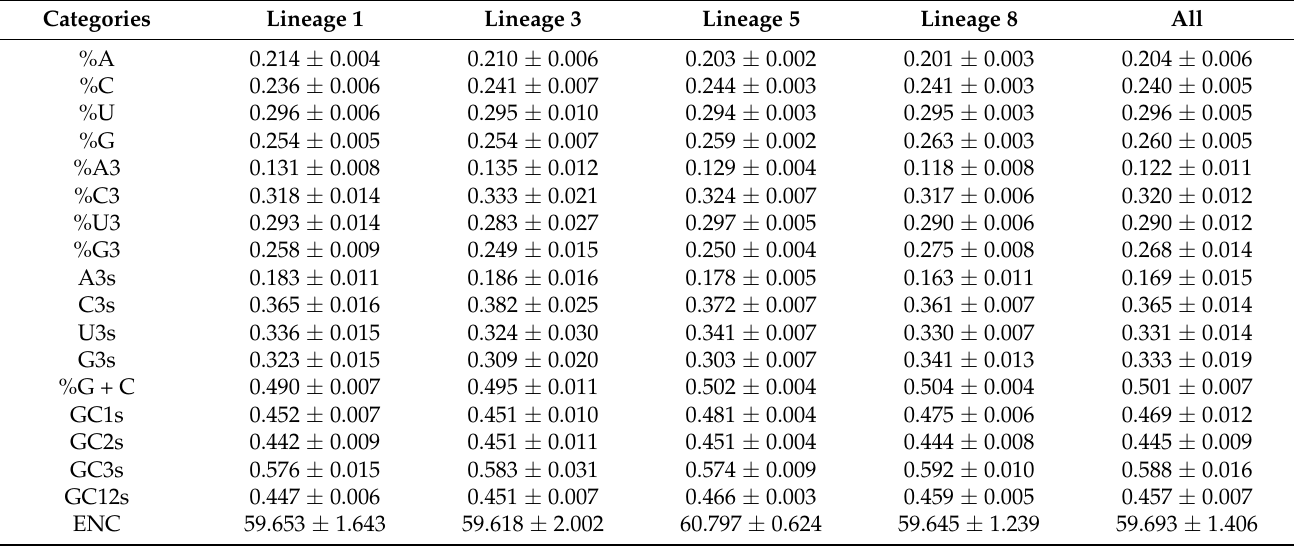
Table 1. Properties of PRRSV ORF5 genes from Chinese strains analyzed in this study (mean value ±